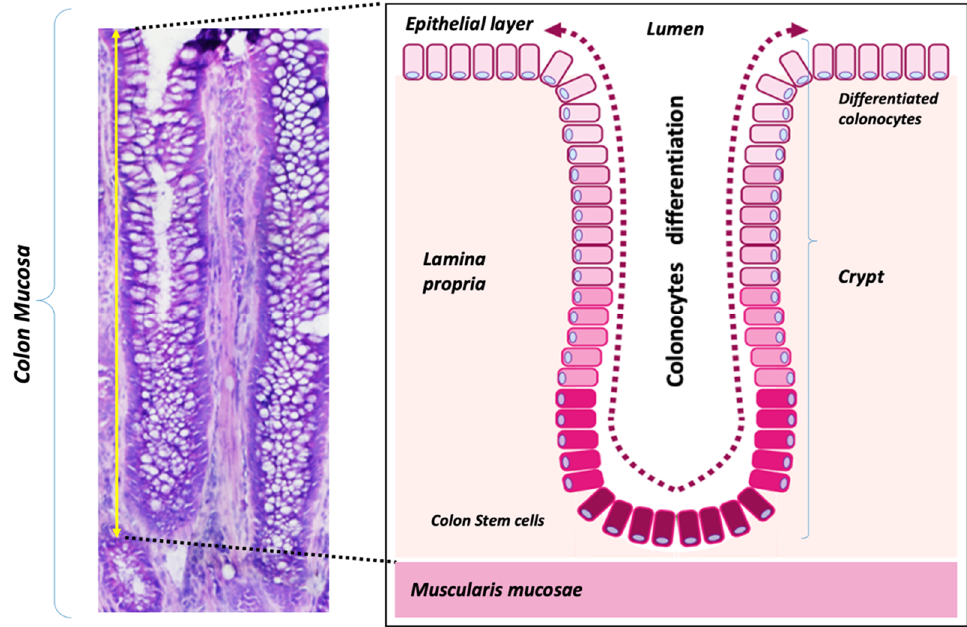
Figure 1. Human colon mucosa tissues. ( a ) Histological sections of a human colon biopsy stained with hematoxylin-eosin showing the three types of basic tissues present in the colon mucosa: the epithelial layer (EP), the lamina propria (LP), and the muscularis mucosae (MM); ( b ) Schematic diagram of a colon crypt, consisting of a single-cell layer of epithelial cells (colonocytes) that invaginates into the lamina propria (stroma). Adult stem cells (in dark red) divide and migrate upward toward the lumen; during this migration, cells undergo a differentiation process to mature colonocytes.